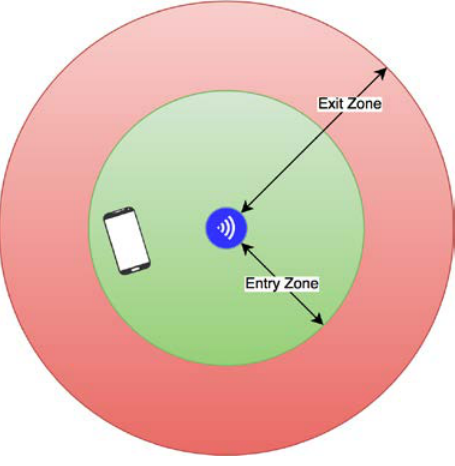
Figure 1. Beacon entry and exit